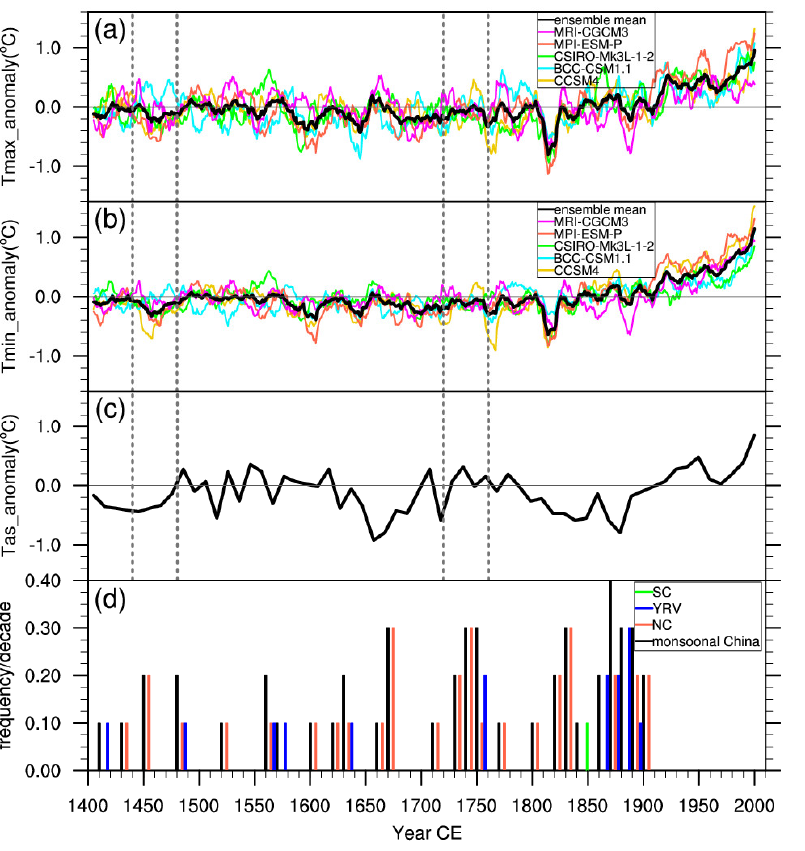
Figure 2. Time series of simulated temperatures, reconstructed temperatures and frequency of warm extreme records. ( a , b ) Simulated 11-year running summer mean Tmax_anomaly, Tmin_anomaly (units: °C) over monsoonal China. ( c ) Reconstructed annual mean Tas_anomaly (units: °C) by Hao et al. over central−east China (105–122° E, 24–36° N). ( d ) Frequency of documented warm extreme records per decade over monsoonal China (black bar), north China (red bar), the Yangtze River Valley (blue bar) and South China (green bar). Different color lines in ( a ) and ( b ) represent individual models and ensemble mean of models. The dotted lines in ( a – c ) represent characteristic warm and cold periods.